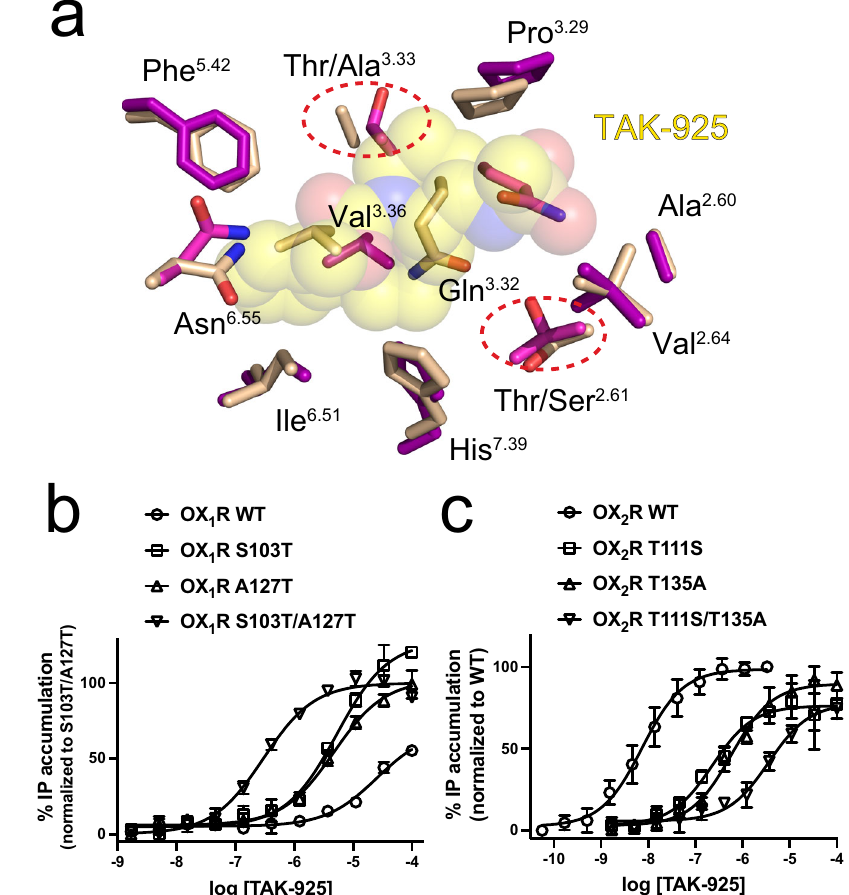
Fig. 3 Structural basis for high selectivity of TAK-925 for OX 2 R. a Overlay of contact residues (sticks with purple carbons for mG sqiN -coupled OX 2 R and sticks with wheat carbons for inactive OX 1 R) within 4 Å of TAK-925 (transparent spheres with yellow carbons) when superimposing OX 2 R-G q and the antagonist-bound inactive conformation of OX 1 R (PDB 4ZJ8). Divergent residues are circled by red dotted lines. b Stimulation of G q by OX 1 R wild type (WT) and subtype-swap single and double mutants when bound to TAK-925. Each data point represents an average from n = 3 independent experiments (each performed in duplicate). Error bars are ±SD. OX 1 R data were normalized to S103T/A127T E max . Data were fi tted to the three-parameter model ‘ log(agonist) vs response ’ in GraphPad Prism 9. Source data are provided as a Source Data fi le. c Stimulation of G q by OX 2 R wild type (WT) and subtype- swap single and double mutants. Each data point represents an average from n ≥ 3 independent experiments (each performed in duplicate), where n is shown in Supplementary Table 2. Error bars are ±SD. OX 2 R data were normalized to OX 2 R WT E max . Data were fi tted to the three-parameter model ‘ log(agonist) vs response ’ in GraphPad Prism 9. Source data are provided as a Source Data fi